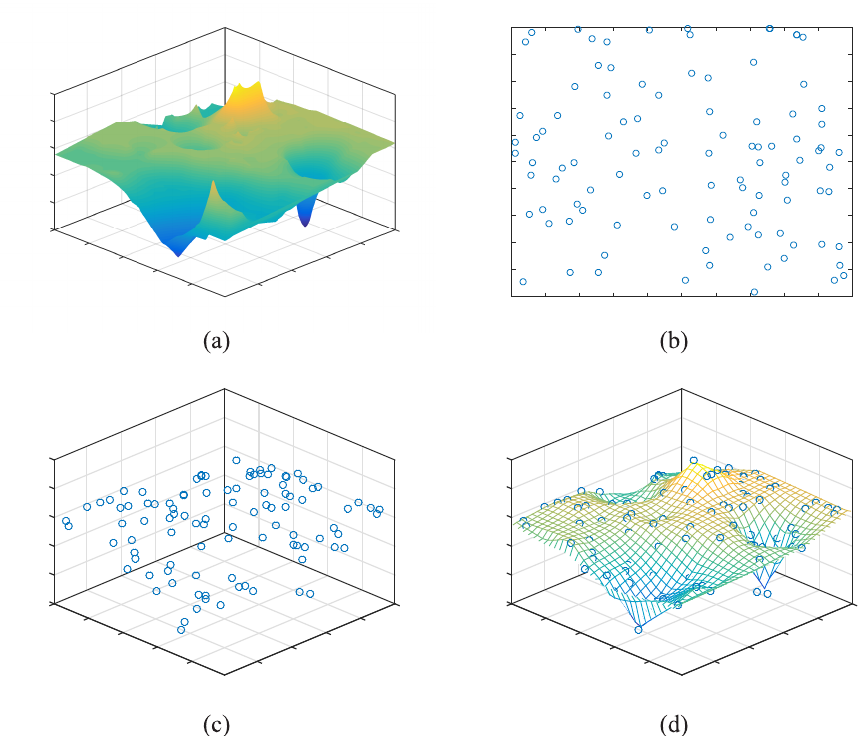
Figure 2. The process of generating sensing image via crowdsensing. ( a ) The 2D signal of CO 2 concentration; ( b ) The distribution of 100 nodes in R with their sending time t i ∈ T ; ( c ) The sampling points of 2D signal; ( d ) Sensing image generated by V